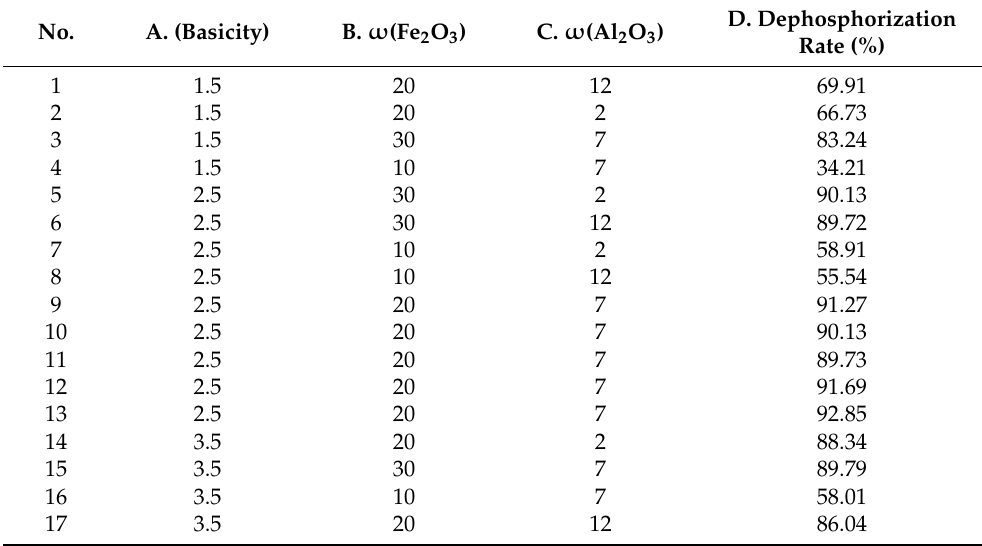
Table 5. Response surface experimental design and results.